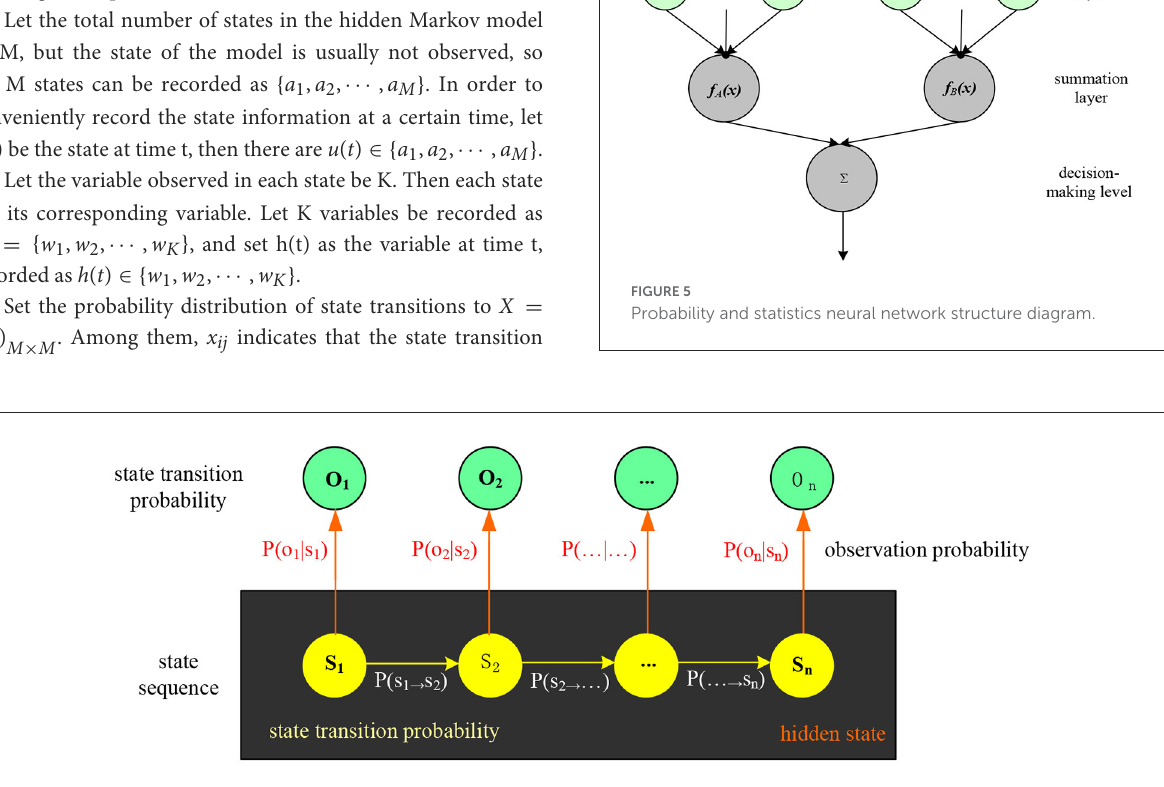
FIGURE4 Hidden Markov Model